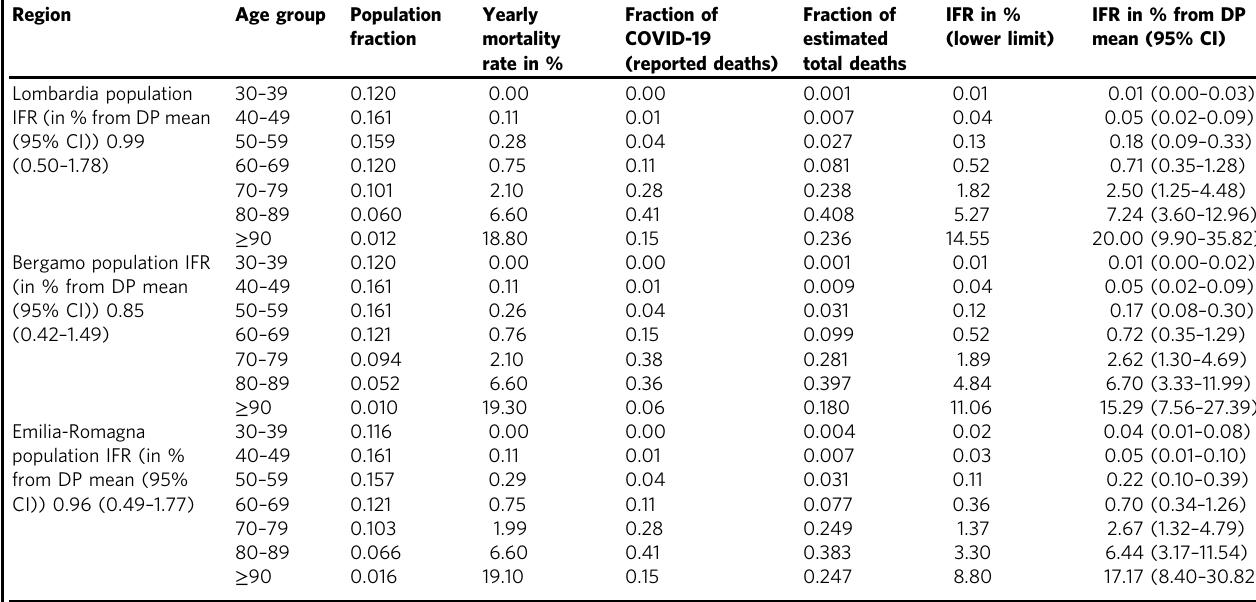
Table 2 Age distribution of fatalities and infection fatality ratios (IFR). Region Age group Population